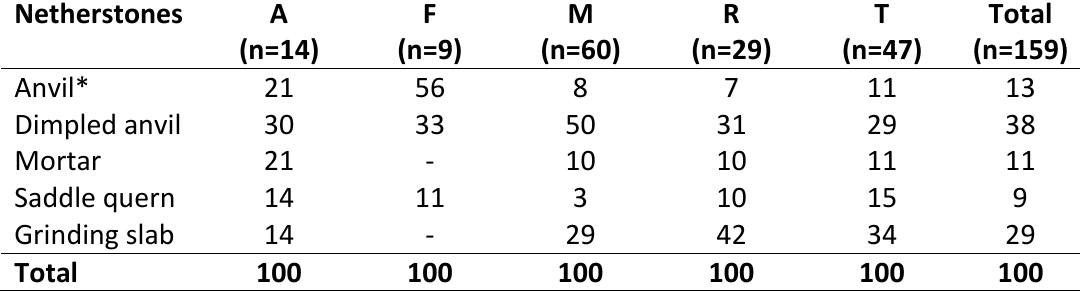
Table 4. Netherstone type frequencies by area. *‘Anvil’ and ‘small anvil’ types are combined in this table. Chi Square = 31.955; Degrees of freedom = 16; p-value = 0.010. As the computed p-value is lower than the significance level alpha = 0.05, one should reject the null hypothesis and accept the alternative hypothesis Ha: there is a link between the rows and